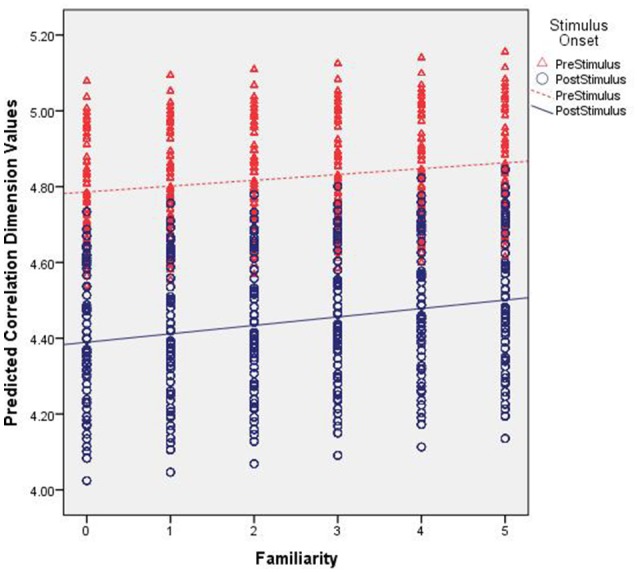
Predicted correlation dimension values. The figure shows the predicted Correlation Dimension (D2) values across increasing levels of familiarity (left to right along the x axis) and segmented by pre- (red triangles) and post-stimulus (blue circles).